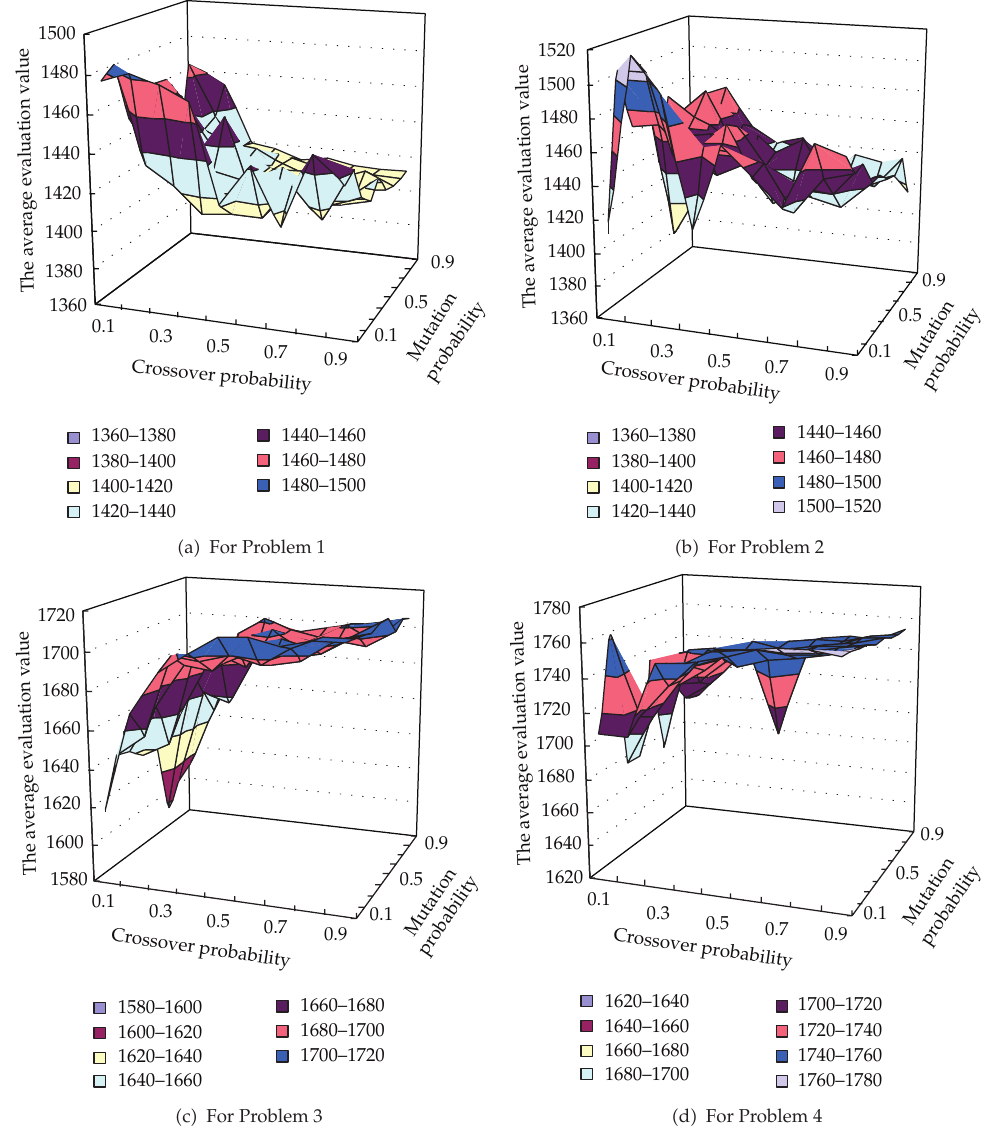
Figure 5: Comparison results with combination of P c and P m